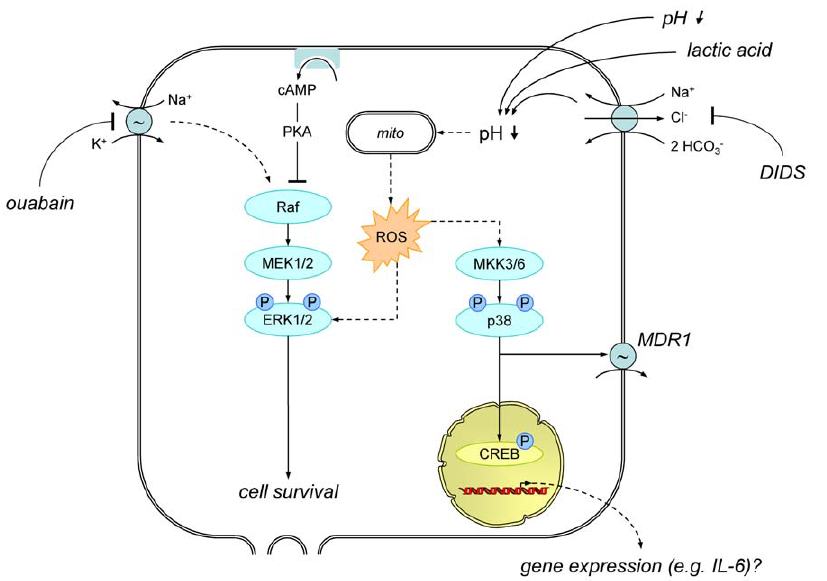
Figure 9. Model of the mechanism by which an acidic microenvironment affects ERK1/2 and p38 phosphorylation and the effects on cellular phenotype.